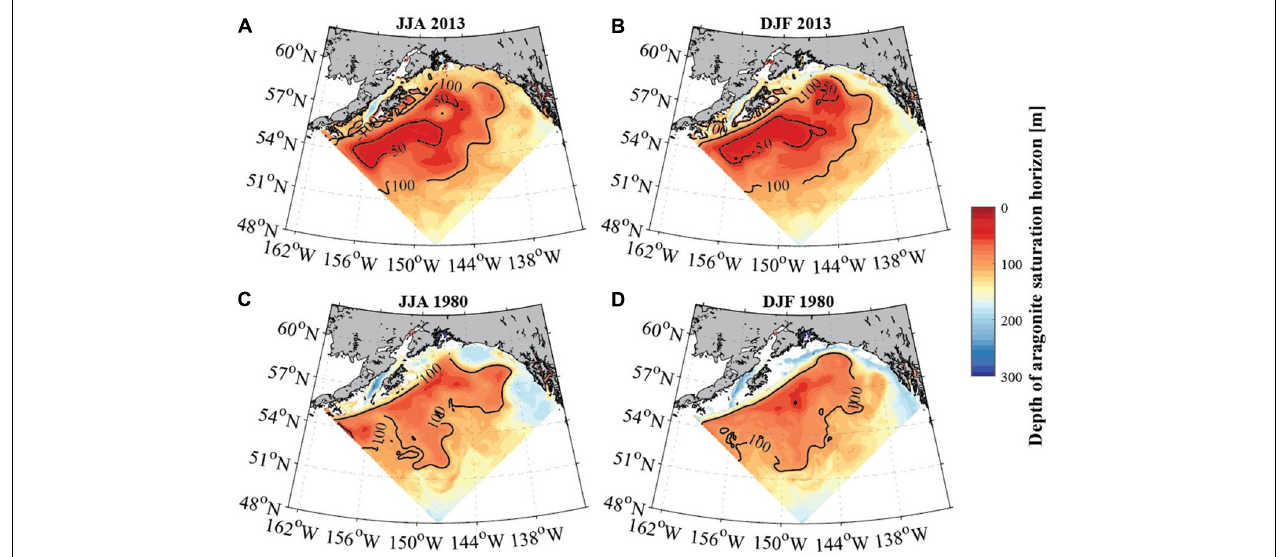
FIGURE 6 | Average seasonal depth of the aragonite saturation horizon [m] in the GoA for June to August ( A,C ; left column) and December to February ( B,D ; right column) for 2013 (top row) and 1980 (bottom row). Solid black contour lines depict depth of the aragonite saturation horizon at 50 and 100 m (modeled data). White areas show locations where the aragonite saturation ( (cid:127) ar ) horizon is deeper than the topography, indicating the absence of undersaturated waters. Model output is from the GOA-COBALT hindcast simulation described by Hauri et al. (2020).